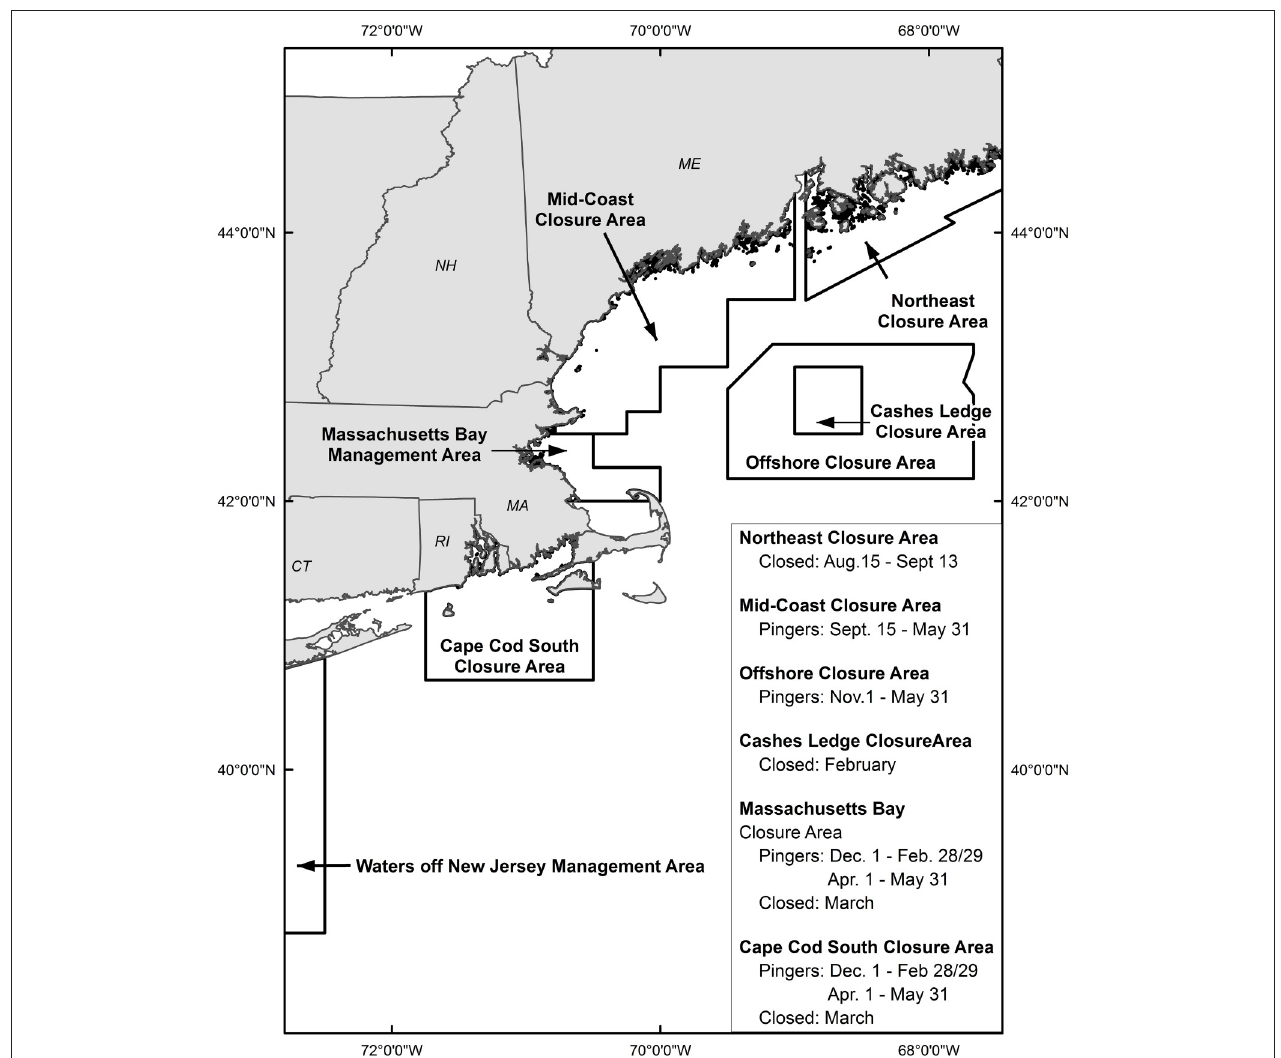
FIGURE 1 | 1998 Harbor porpoise TRT management areas in the northeast (NMFS,